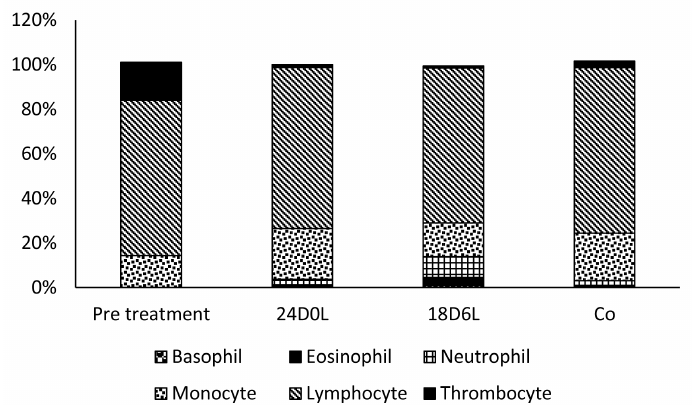
Figure 2. Population of white blood cells types in Pangasionodon hypophthalmus reared under manipulated photoperiod. 24D0L, 24 hours of darkness; 18D6L, 18 hours of darkness; Co, control – normal